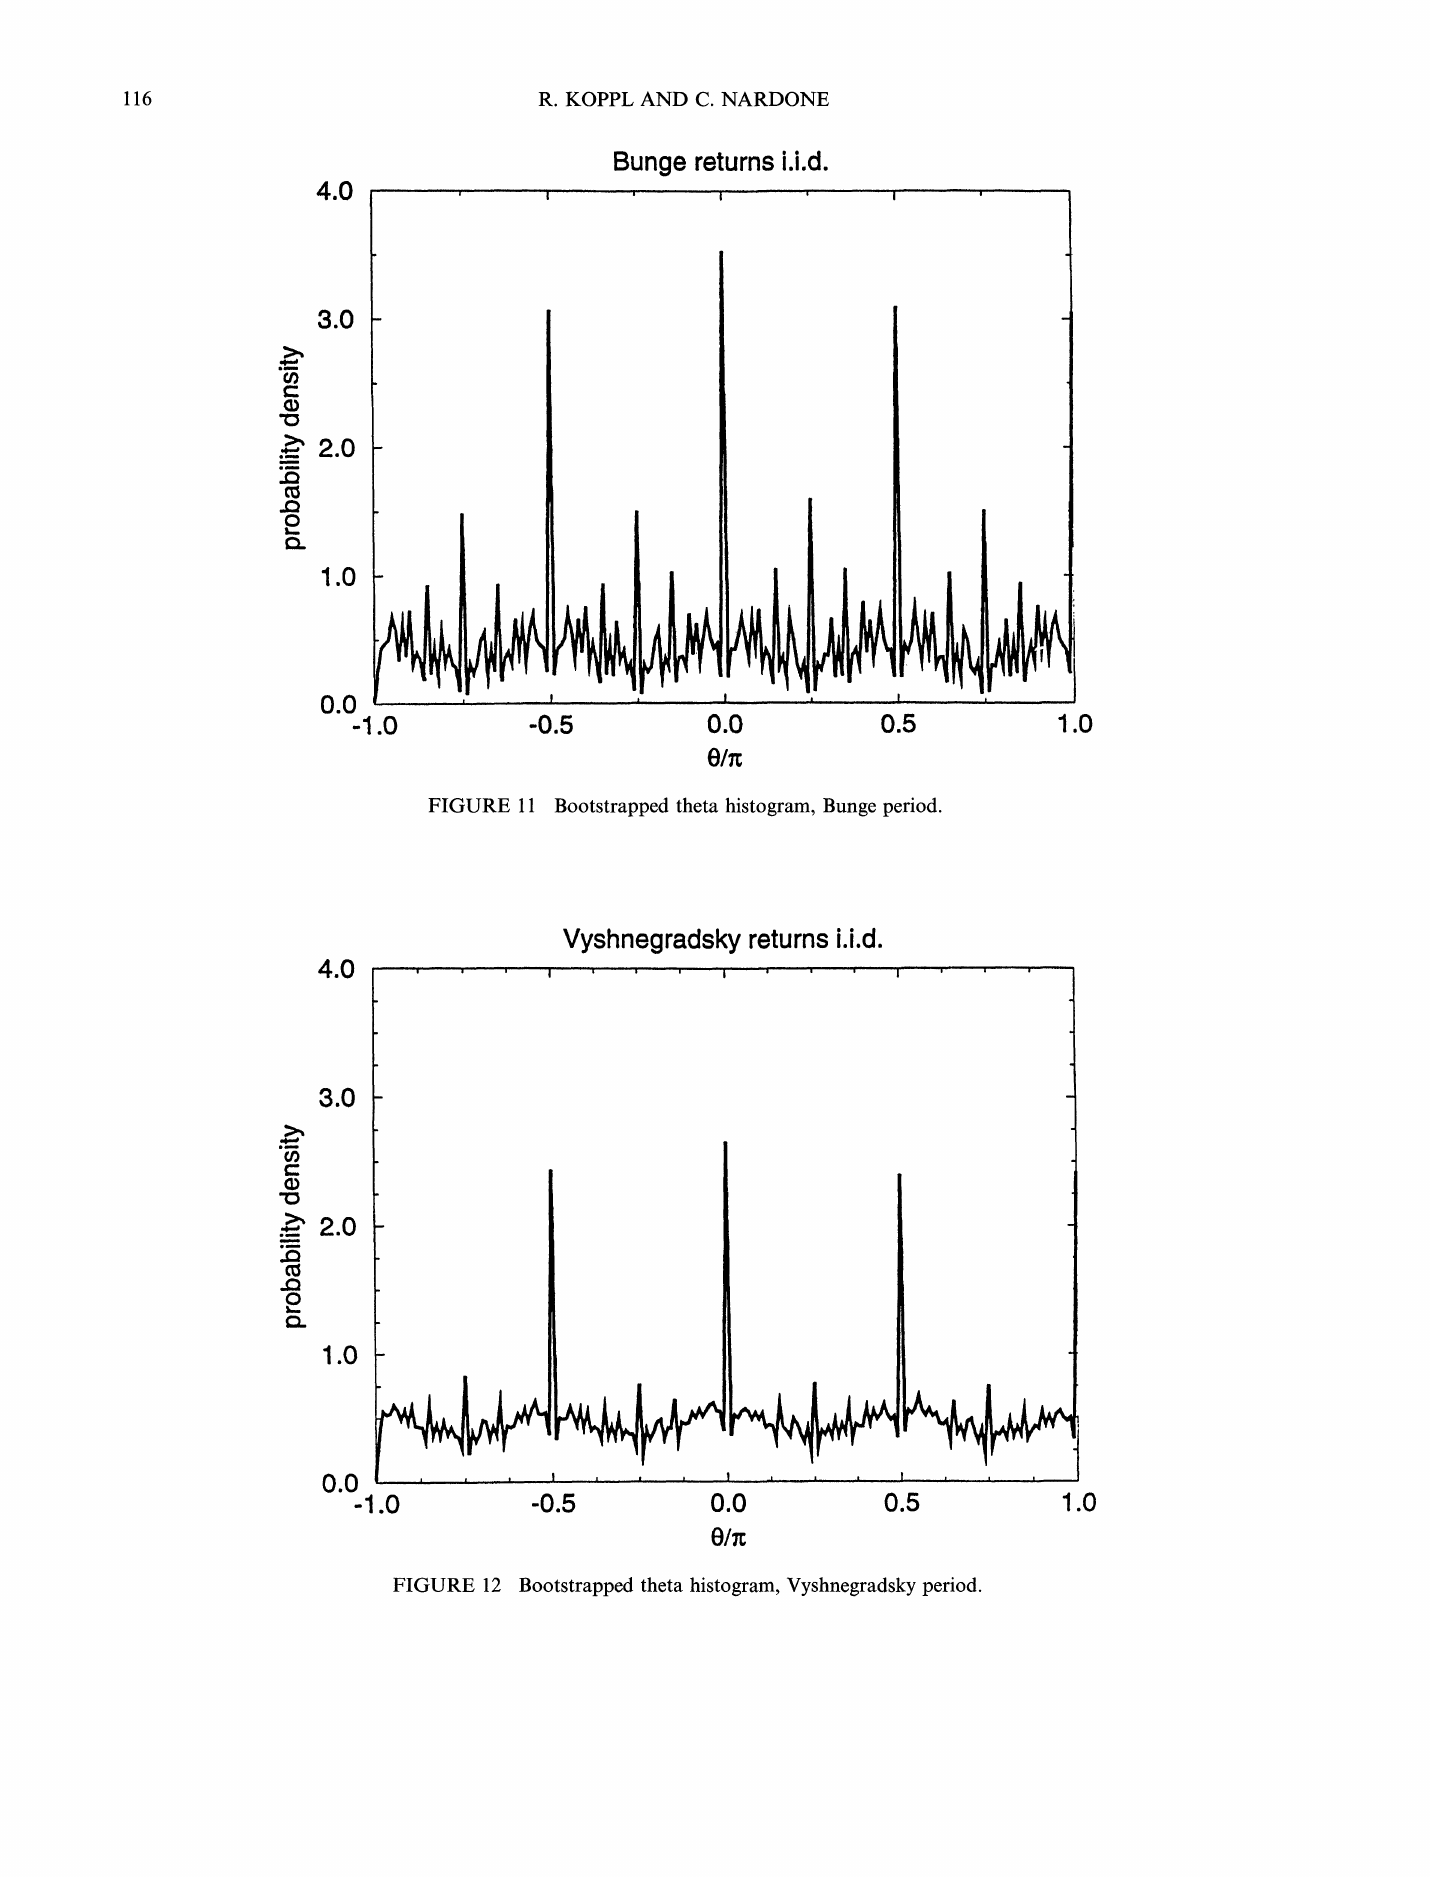
FIGURE 11 Bootstrapped theta histogram, Bunge period.